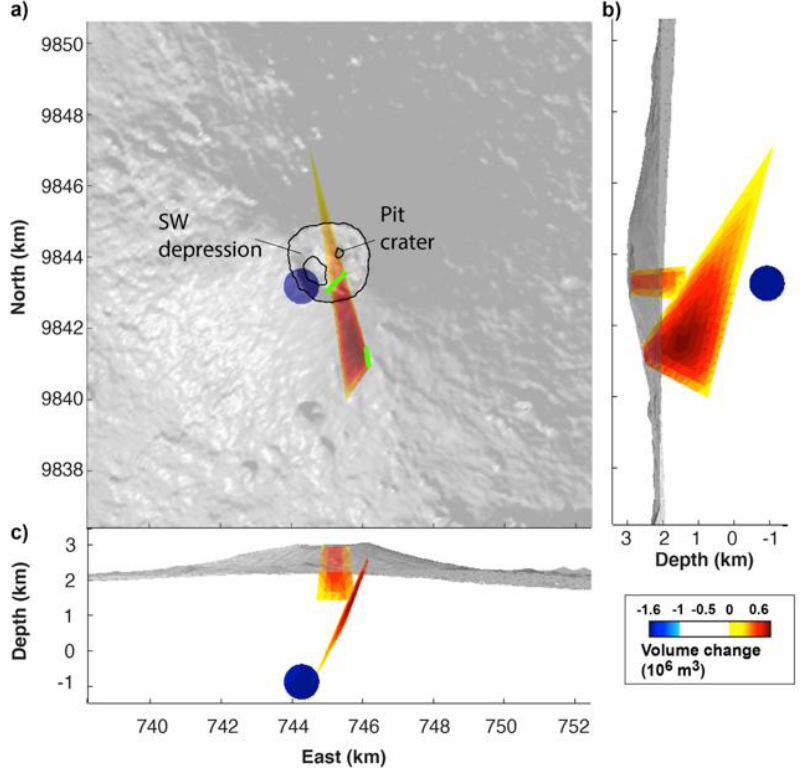
Figure 3. Geometry of the preferred best-fit model including two dikes and a deflating reservoir: ( a ) Map view. The 2010 eruptive fissures are shown as bold green lines. ( b ) North-vertical cross-section. ( c ) East-vertical cross-section. Volume changes of the dike associated with the caldera’s fissure, the southern flank’s fissure and the spherical reservoir are 0.74, 4.2 and −5.1 × 10 6 m 3 ,